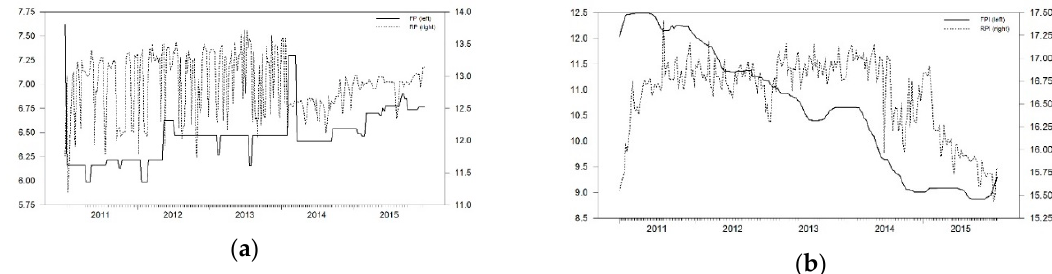
Figure 1. Evolution of Farm-Retail price series. ( a ) Farm-Retail prices for Generic Caciotta cheese; ( b ) Farm-Retail prices for protected designation of (PDO) Parmigiano Reggiano cheese. Table 1. Summary of descriptive statistics.